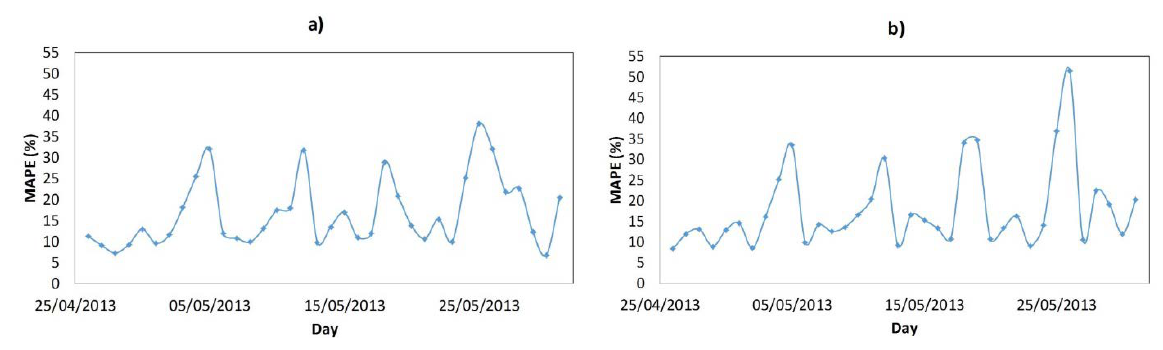
Figure 13. Daily Average MAPE (%) (1) of the winning architecture: ( a ) F_L_W_M ; ( b ) F_L_W_M_SR